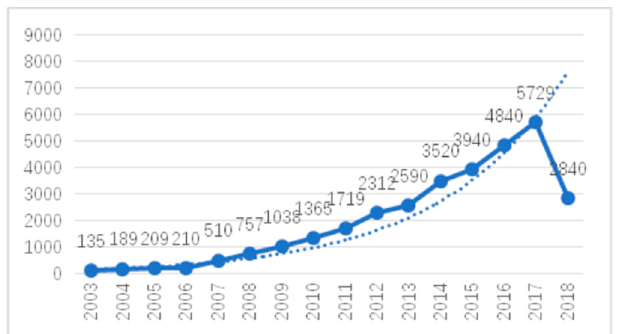
Figure 2. Annual number of authors.